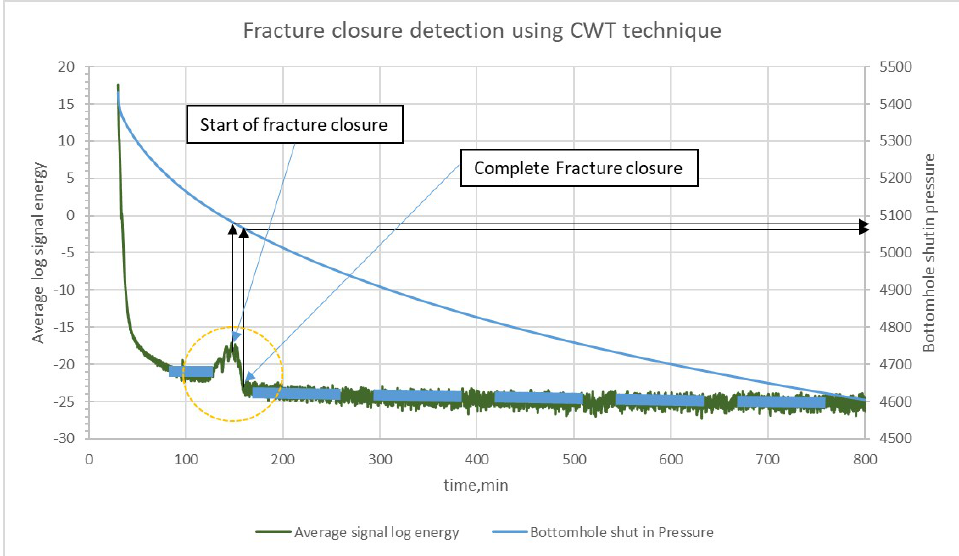
Figure 6. Fracture closure pressure using CWT closure detection